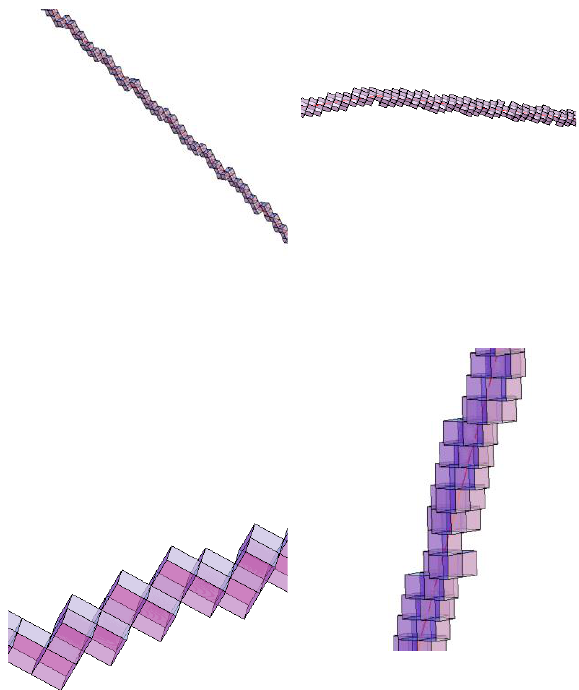
Figure 8. The detail effect in the cube